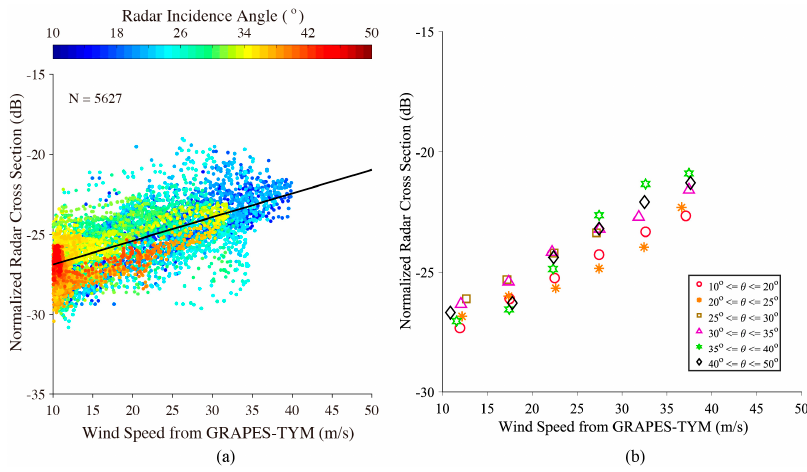
Figure 5. ( a ) The relationship between VH-polarization GF-3 NRCS and wind speed, in which the black line represents the linear fitting result. ( b ) Average NRCS of VH-polarization Gaofen-3 SAR versus wind speed between 10 m/s and 40 m/s for a 5 m/s bin at various incidence angle ranges.